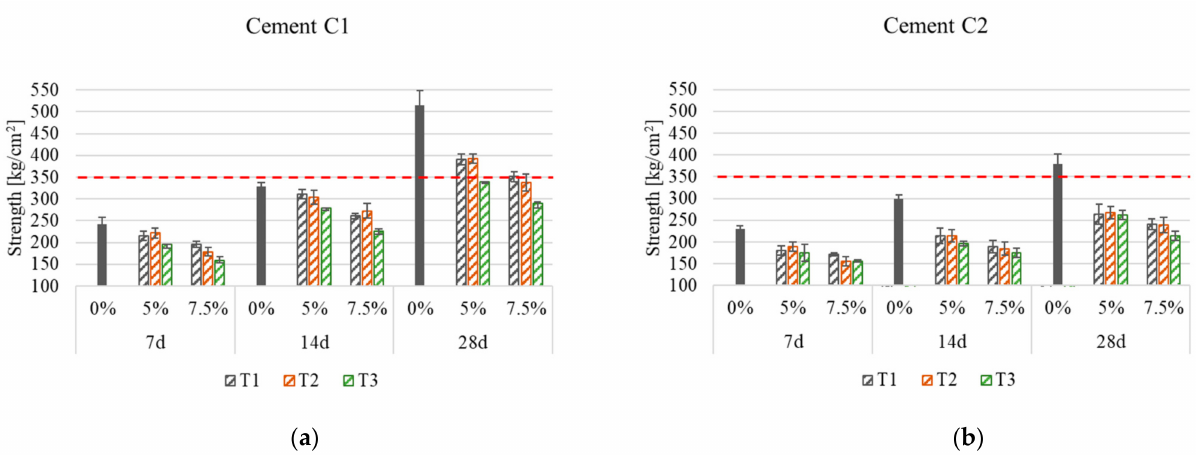
Figure 15. Compressive strength of rubber-added mortar samples under treatment R1 at 5% and 7.5% replacement, after 7, 14, and 28 days: ( a ) cement C1; ( b ) cement